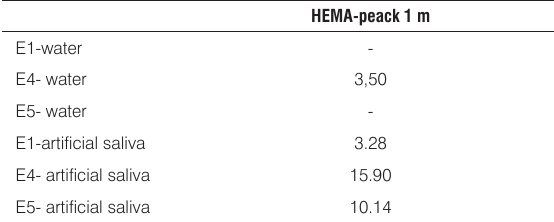
Table 2. Results of residual